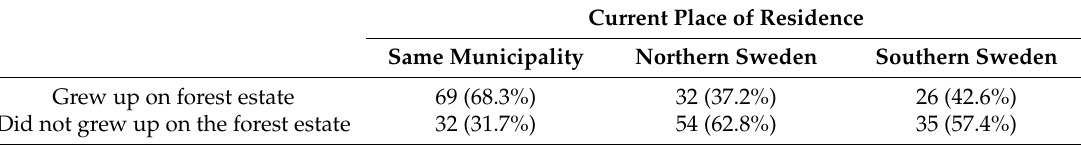
Table 2. The relationship between the place where the respondents grew up and the place where they currently live, number